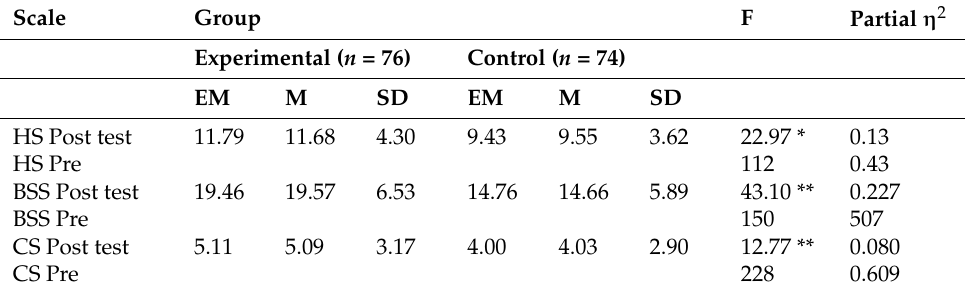
Table 2. ANCOVA test for the Head Scale, the Body Schema Scale, and the Clothing Scale following the application of the intervention plan.